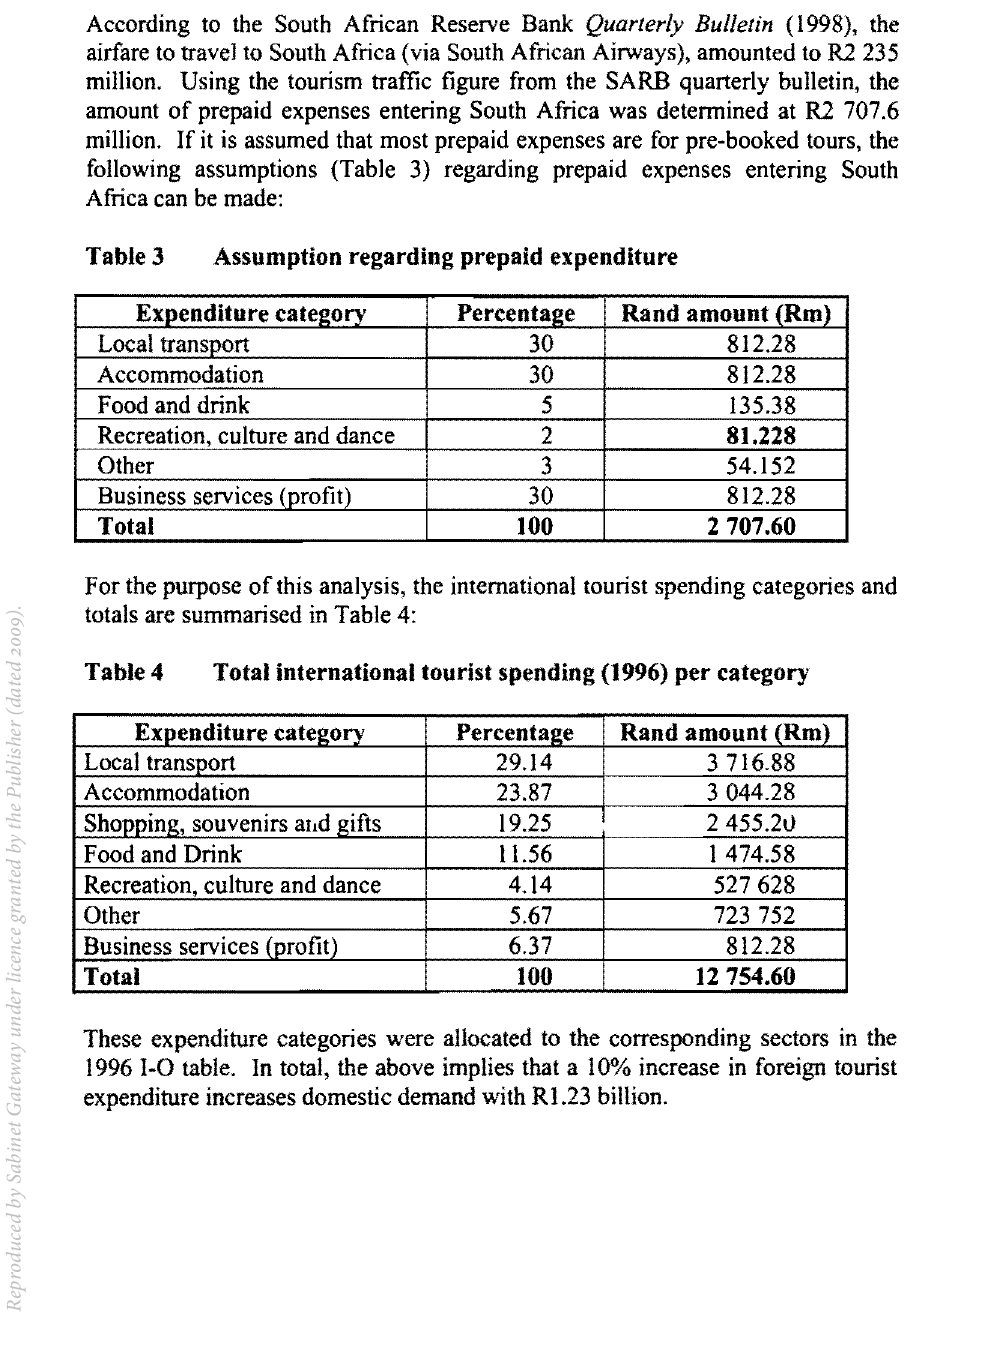
Total international tourist spending (1996) per